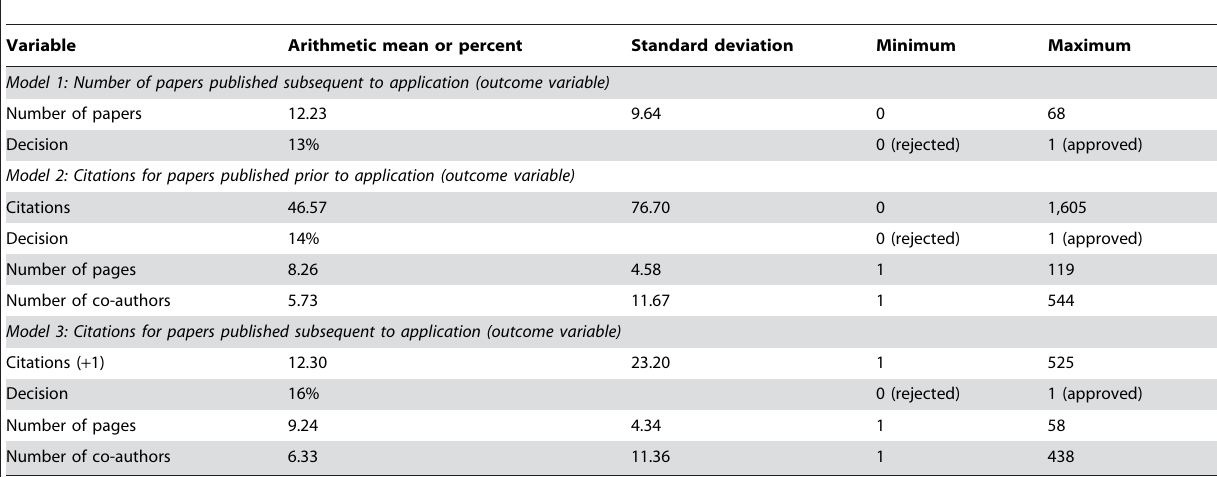
Table 3. Description of the factors that were potentially associated with quantity and impact of research publications (applicants for the YI programme).